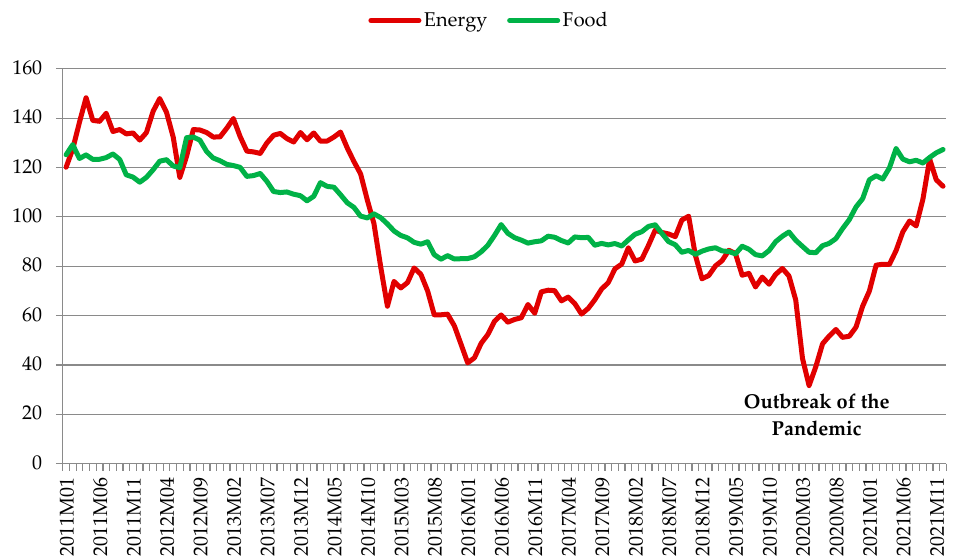
Figure 4. Formation of the monthly world energy and food price indices in 2011–2021.